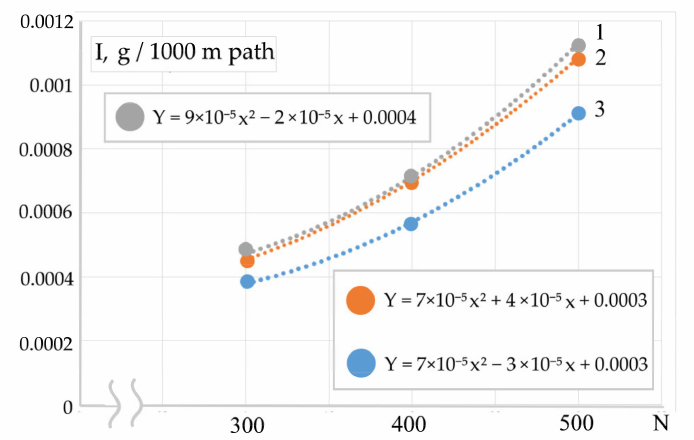
Figure 5. The wear of P900 steel after contact with liquids: 1 — Shell HF-E 46 (synthetic); 2 — Shell HF-R (biological origin); 3 — LCLp 3%; 4 — LCLp 5%; 5 — LCLp 1%; 6 — I-12A.